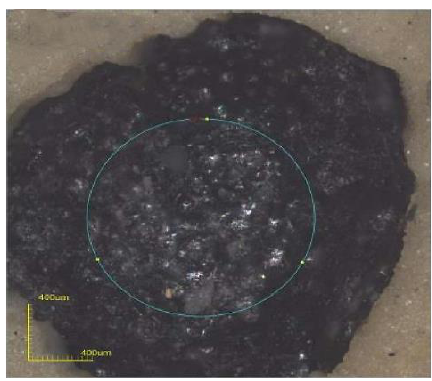
Figure 3. Scanning topography of ferrochrome slag by laser confocal electron microscope .